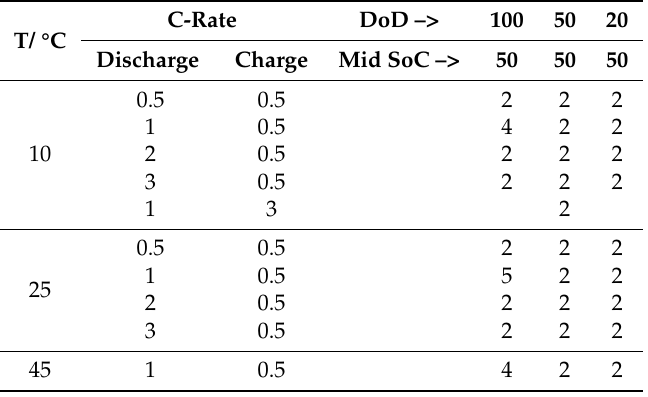
Table 2. General overview of the cycling test matrix. SoC: state of charge, T: Temperature